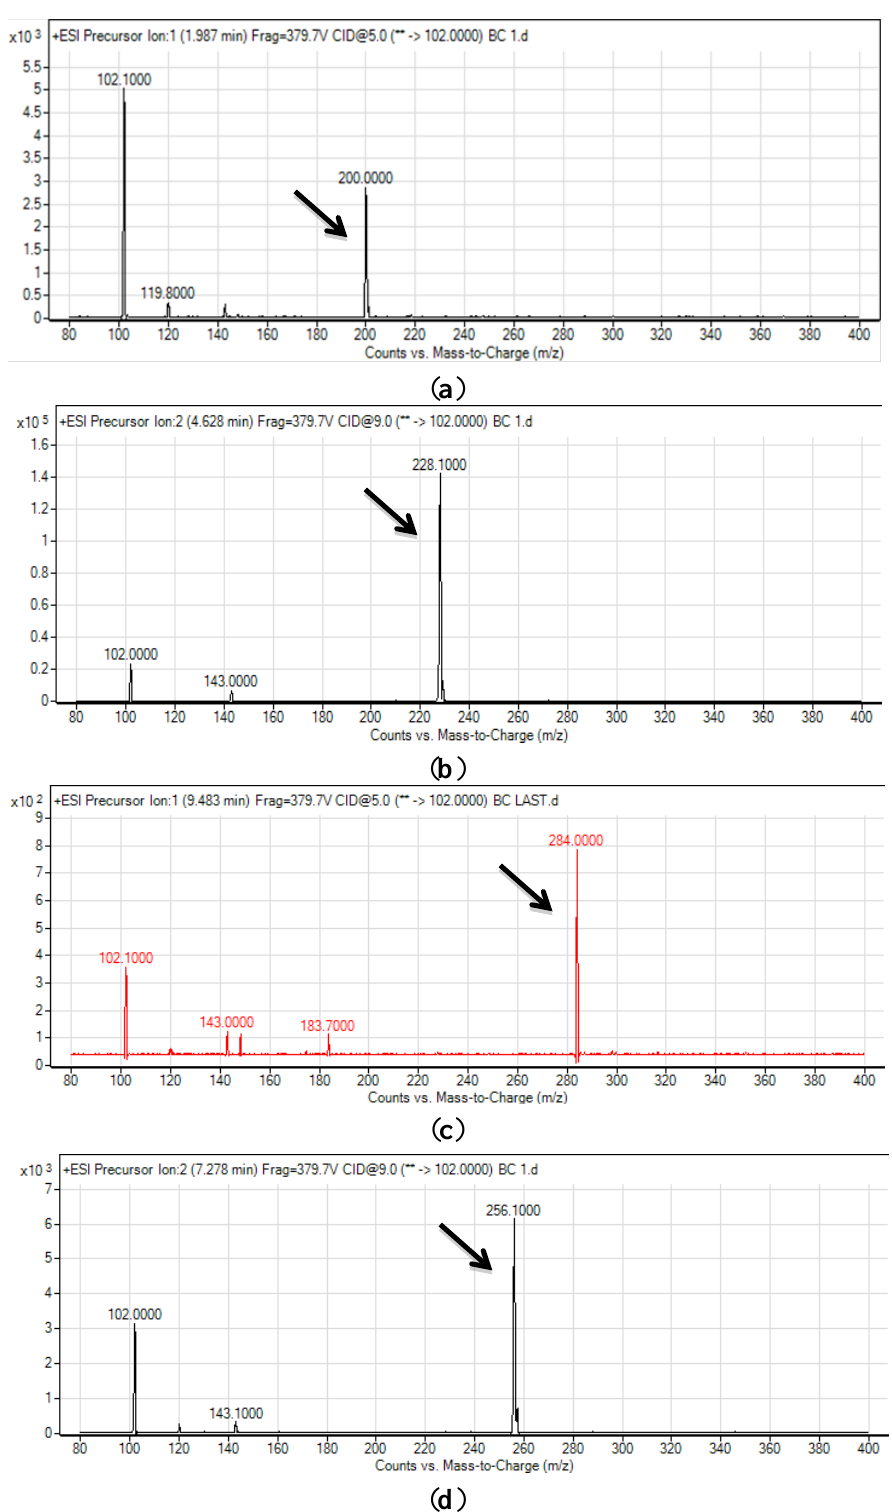
Figure 3. Mass spectrometry analysis of spent supernatant extract of Burkholderia sp. strain C10B. All corresponding m/z for respective AHLs are marked by arrows; ( a ): mass spectrum of C6-HSL ( m/z 200.0000), ( b ): mass spectrum of C8-HSL ( m/z 228.1000), ( c ): mass spectrum of C10-HSL ( m/z 256.1000), ( d ): mass spectrum of C12-HSL ( m/z